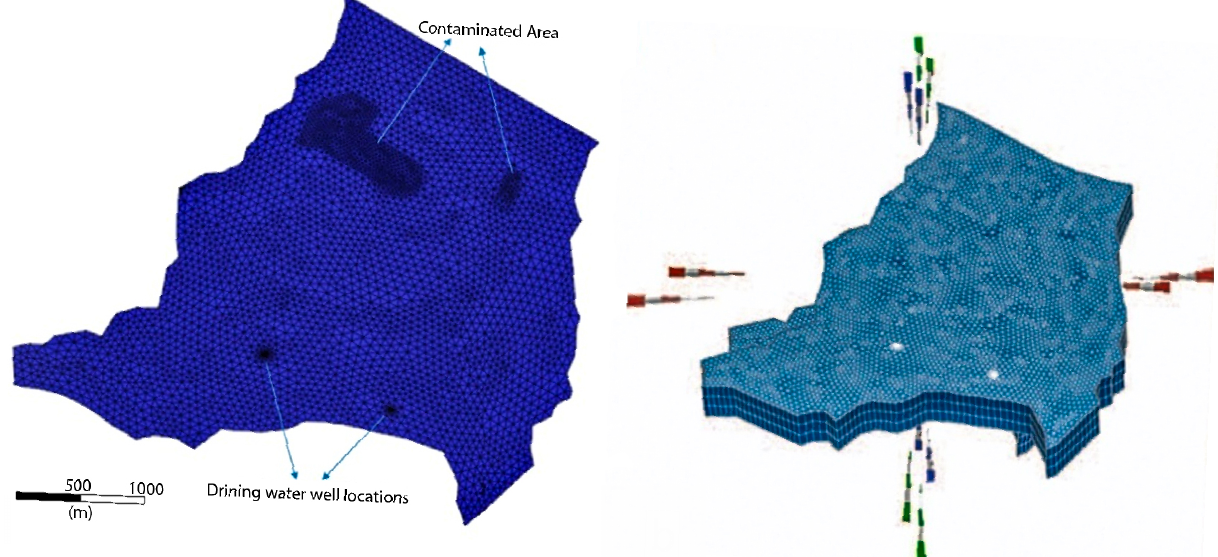
Figure 4. Model domain showing super mesh with high mesh resolution at the contaminated and drinking water well locations, 3D